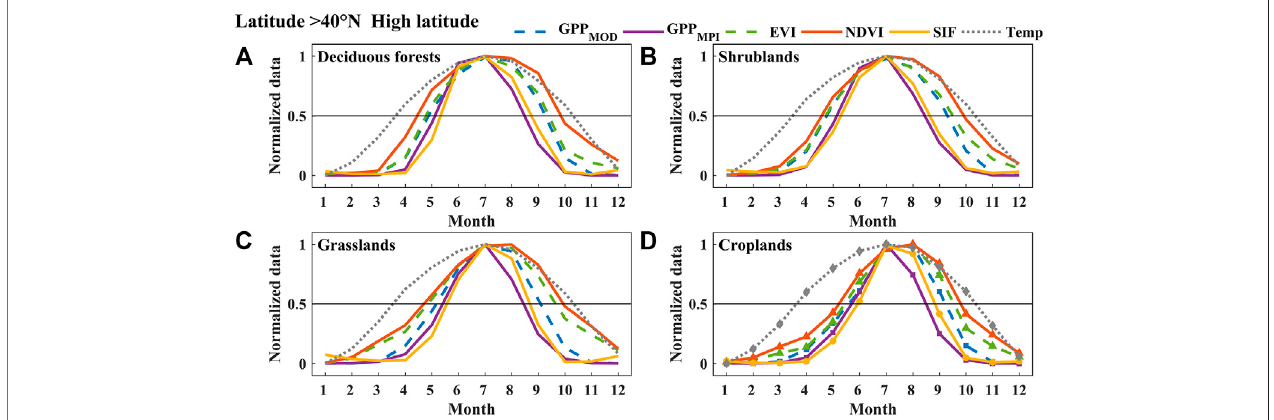
FIGURE 4 | The normalized mean seasonal cycle of area-averaged GPP MOD , GPP MPI , NDVI, EVI, SIF, and Temperature (Temp) of deciduous forests (A) , shrublands (B) , grasslands (C) , and croplands (D) in the high-latitude region (over 40 ° N) of China between 2007 and 2013. Error bars in all subplots represent the monthly standard deviations during 2007 – 2013.